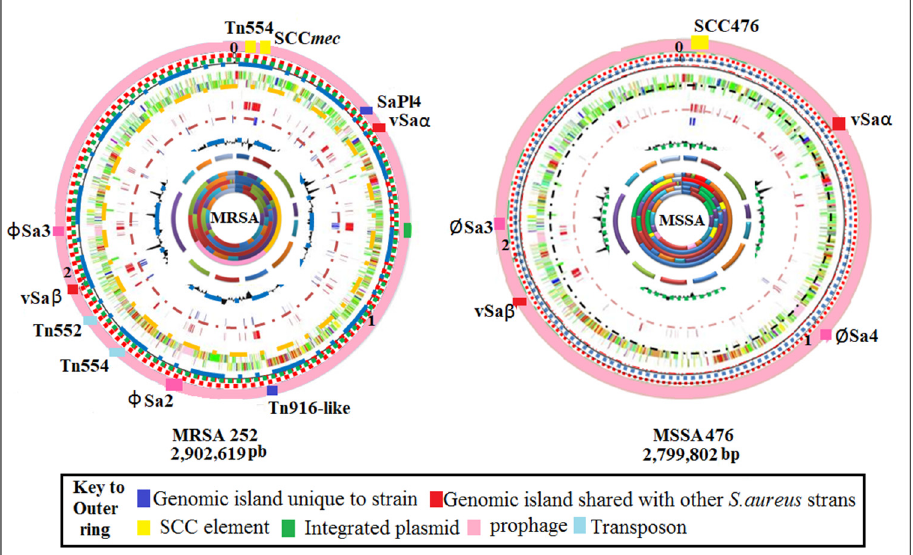
Figure 1. Circular diagram of the MRSA 252 and MSSA 476 chromosomes. Colored segments on the outer ring (pink): genomic islands and horizontally acquired DNA. Rings inside and moving internally represent annotated CDS (in Mbp). tRNA and rRNA (green), additional DNA compared to other S. aureus strains (red and blue), percentage of G + C content, and G + C deviation (>0%, olive; <0%, purple). Predicted function coding for CDSs: pathogenicity/adaptation (royal blue); energy metabolism (black); information transfer (red); surface-associated (dark green); degradation of large molecules (cyan); degradation of small molecules (magenta); central/intermediary metabolism/intermediary metabolism (multi-colored); unknown (light green); regulators (light blue); conserved hypothetical (multi-colored segments); pseudogenes (brown); phage plus insertion sequence elements (pink); miscellaneous (grey). Adapted from Holden et al. [27]